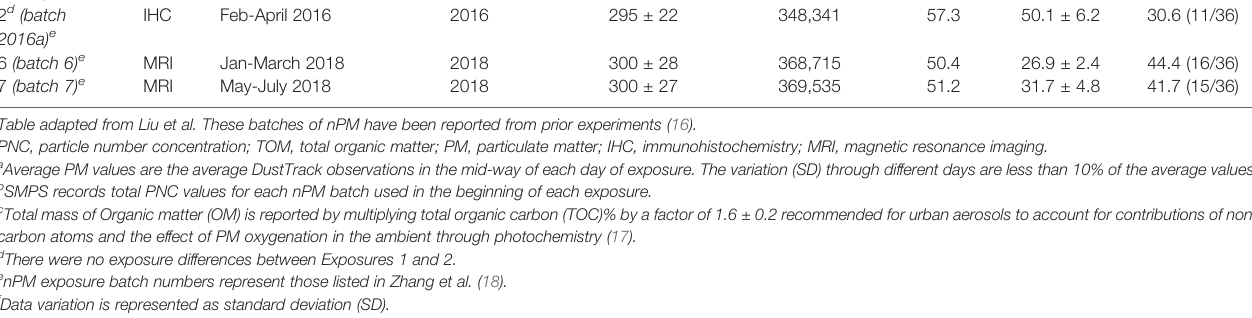
images with temporal resolution of 1.4 s, FA 15°, TR/TE = 18/ 3ms, slice thickness 1 mm, in-plane resolution 120x230 m m 2 ).